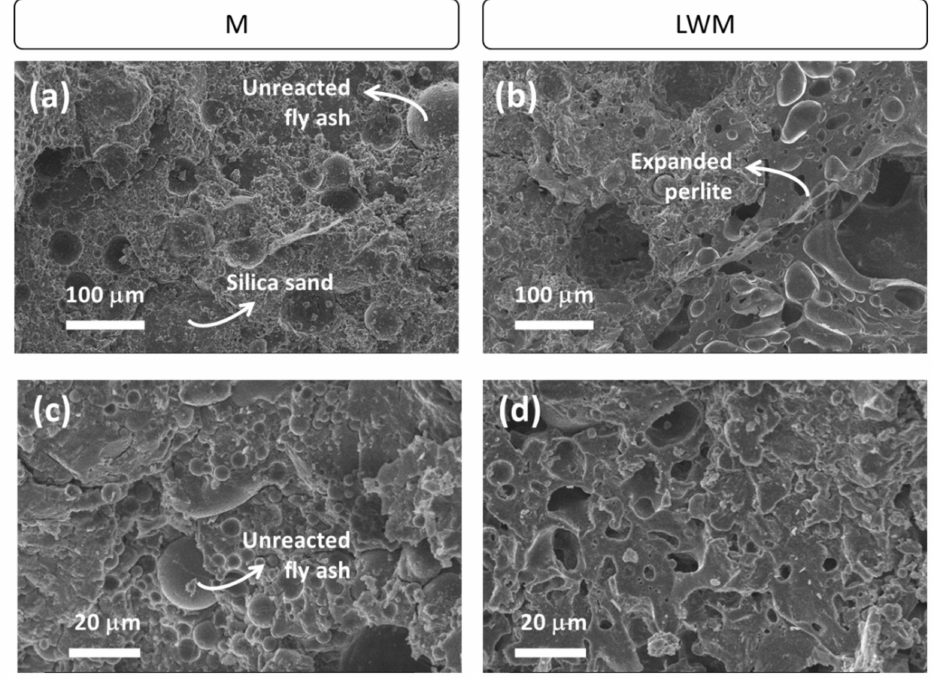
Figure 4. SEM morphological observation of ( a , c ) M and ( b , d ) LWM samples at different magnifica- tions: ( a , b ) at 200 × and ( c , d ) at 1000 ×